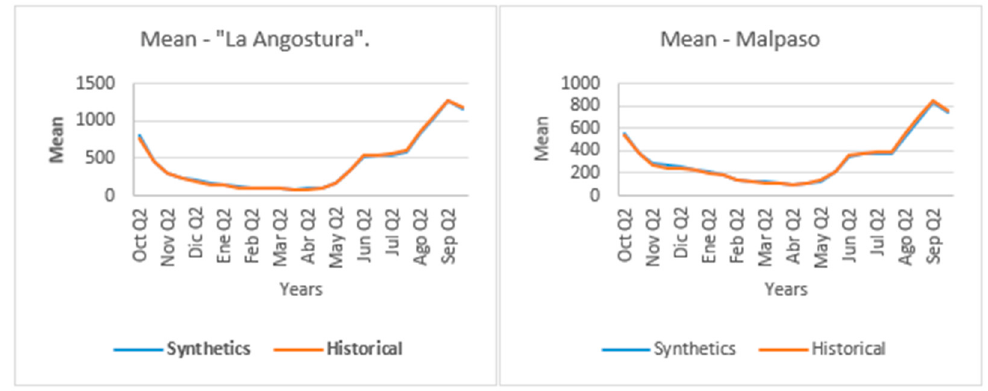
Figure 4. Comparison of the mean, average of the 10 synthetic series vs. historical series of La Angostura and Malpaso Dams.